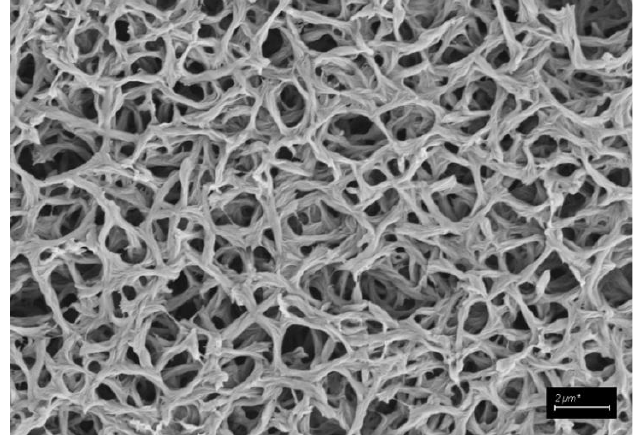
Figure 3. SEM image of the nylon membrane. The SEM operated at an accelerating voltage of 20 kV.